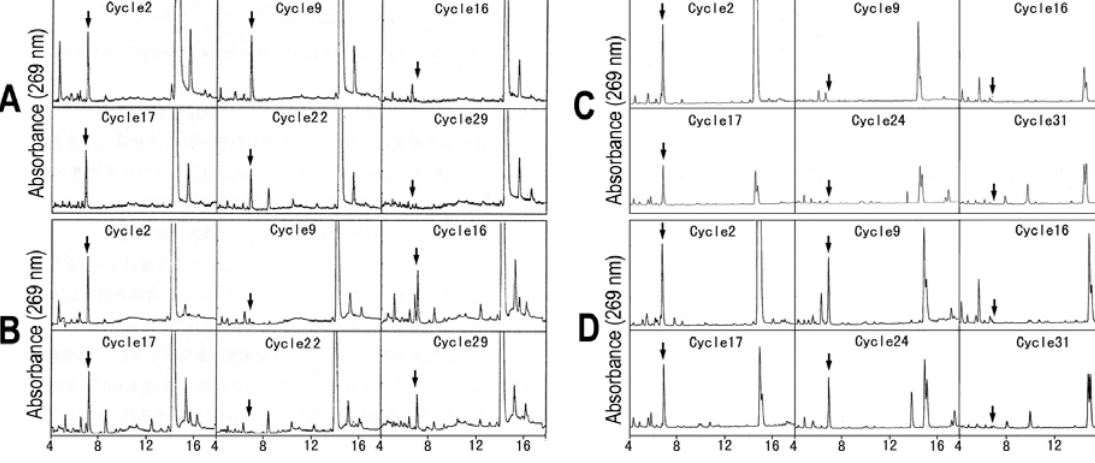
Disulfide Linkage Pattern of HNTX-III and